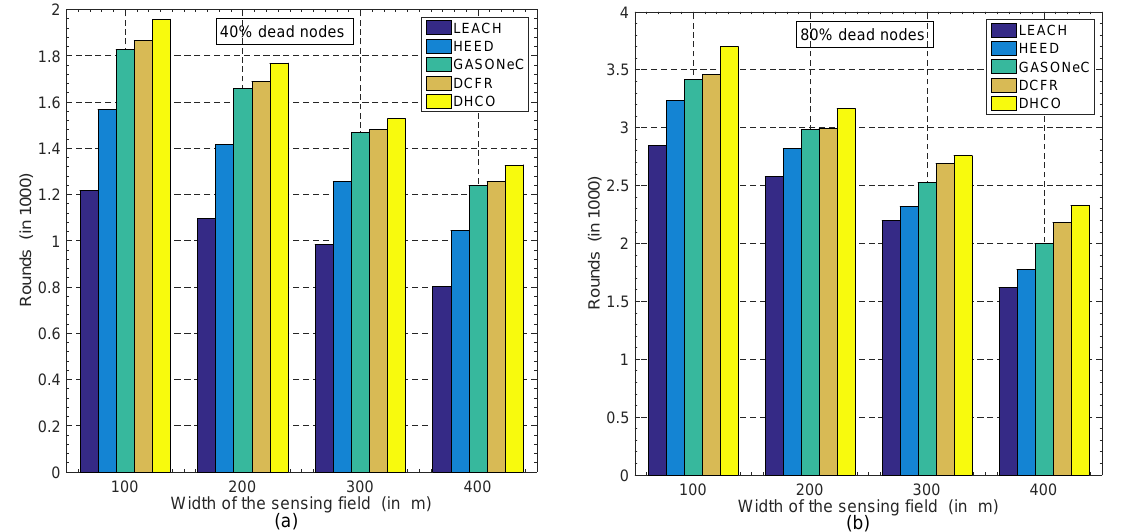
Figure 5. Comparison of transmission rounds with different dead sensor nodes for various algorithms in the deployment scenarios of 100 sensor nodes of a random distribution and the coordinate (50, 50) of the BS: ( a ) at the 40% dead-sensor-nodes level for different widths of the sensing field, and ( b ) at the 80% dead-sensor-nodes level for different widths of the sensing